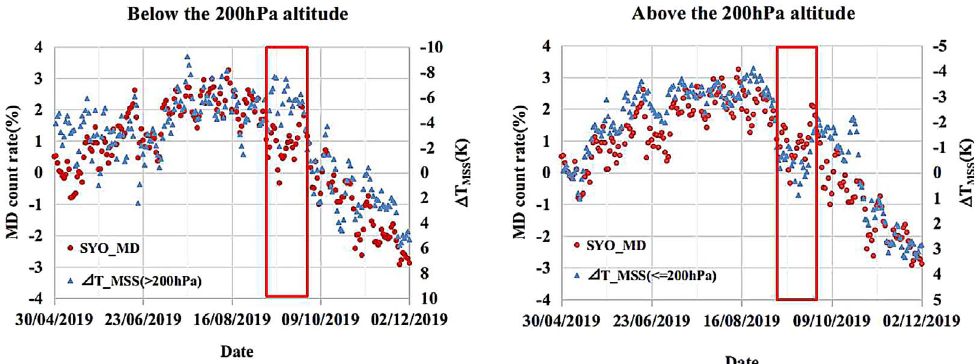
Fig. 13. Pressure corrected daily mean SYO_MD_V count rate shown by red solid circles and the left vertical axis. D T MSS (calculated with Eq. (3)) is shown by blue solid circles on the right vertical axis using an inverted scale. The left panel is calculated from the temperature below the 200 hPa altitude and the right panel from the temperature above the 200 hPa altitude. The SSW event is indicated by a red rectangle in both panels. Minor tick marks on the horizontal axis are indicated every 27